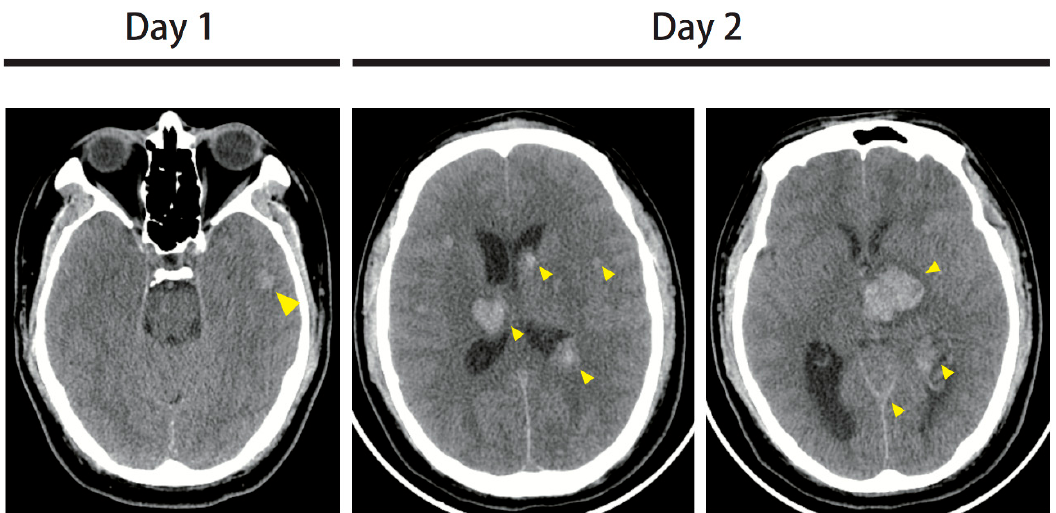
Figure 1. On the day 1 brain computed tomography (CT), a 13 mm lesion with hyperdensity was found in the left temporal region, with suspected intracerebral hemorrhage. On the day 2 brain CT, multifocal intracranial hemorrhages in bilateral cerebral hemispheres were noted, the largest being a 30 mm lesion in the left thalamus. The midline structures were shifted to the right side. Extensive swelling was present in the cerebellum and brain stem. Table 1. The laboratory evaluation in this patient.